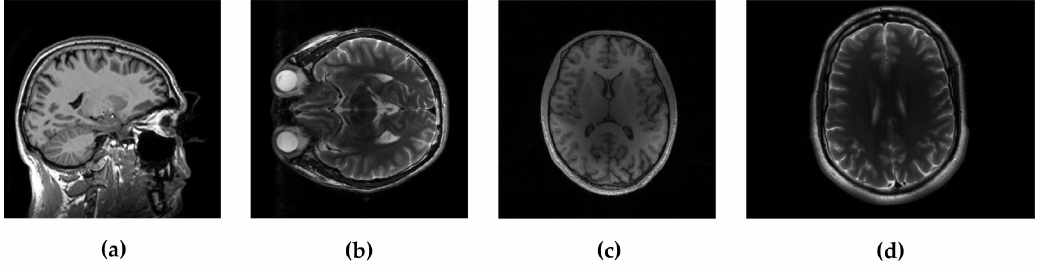
Figure 2. Test images: ( a ) sagittal , ( b ) axial-1 and ( c ) axial-2 , all three 256 × 256, and ( d ) axial-3 with resolution 256 ×